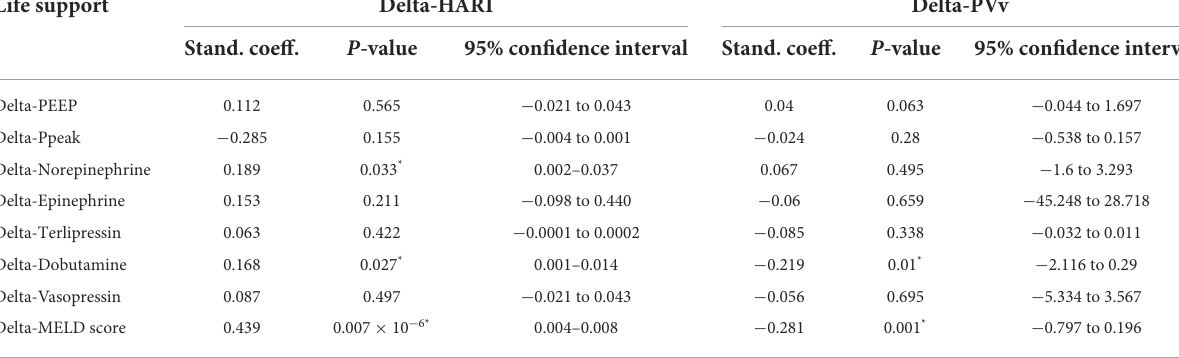
TABLE 4B Multiple regression analyses between life support in the MICU and liver perfusion. Life